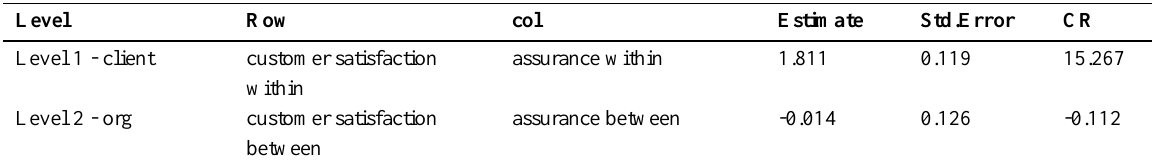
Table 3: The effect of assurance on customer satisfaction